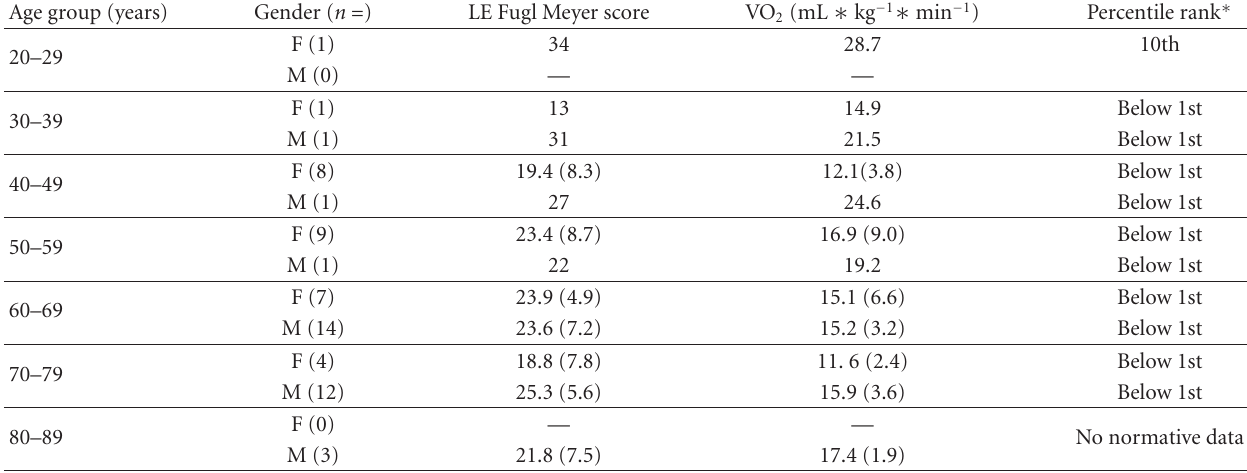
Table 3: Age comparison of cardiopulmonary exercise test parameters and LE